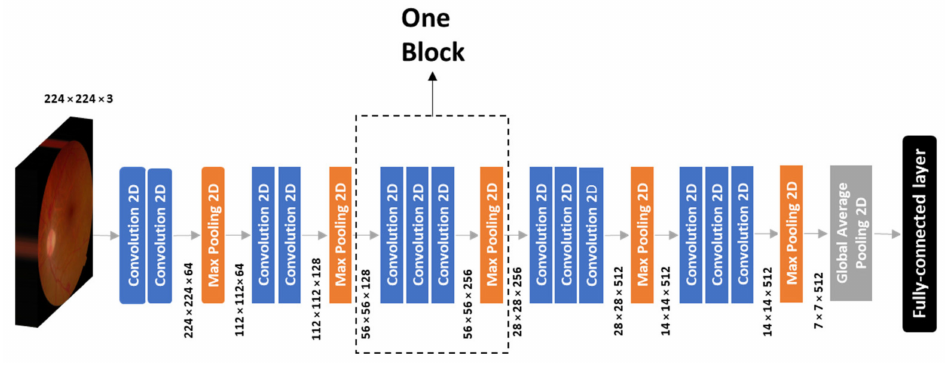
Figure 5. Architecture of the VGG16 model.